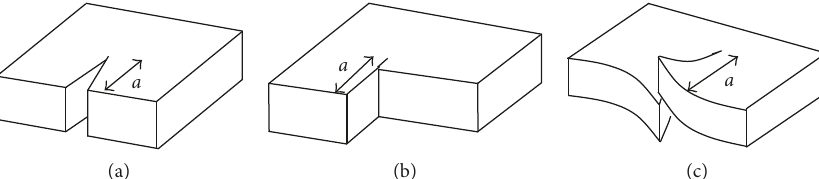
Figure 3: Three fundamental modes of a crack. (a) Mode I: opening of the crack (extension). (b) Mode II: sliding of the crack (shearing). (c) Mode III: tearing of the crack (twisting).